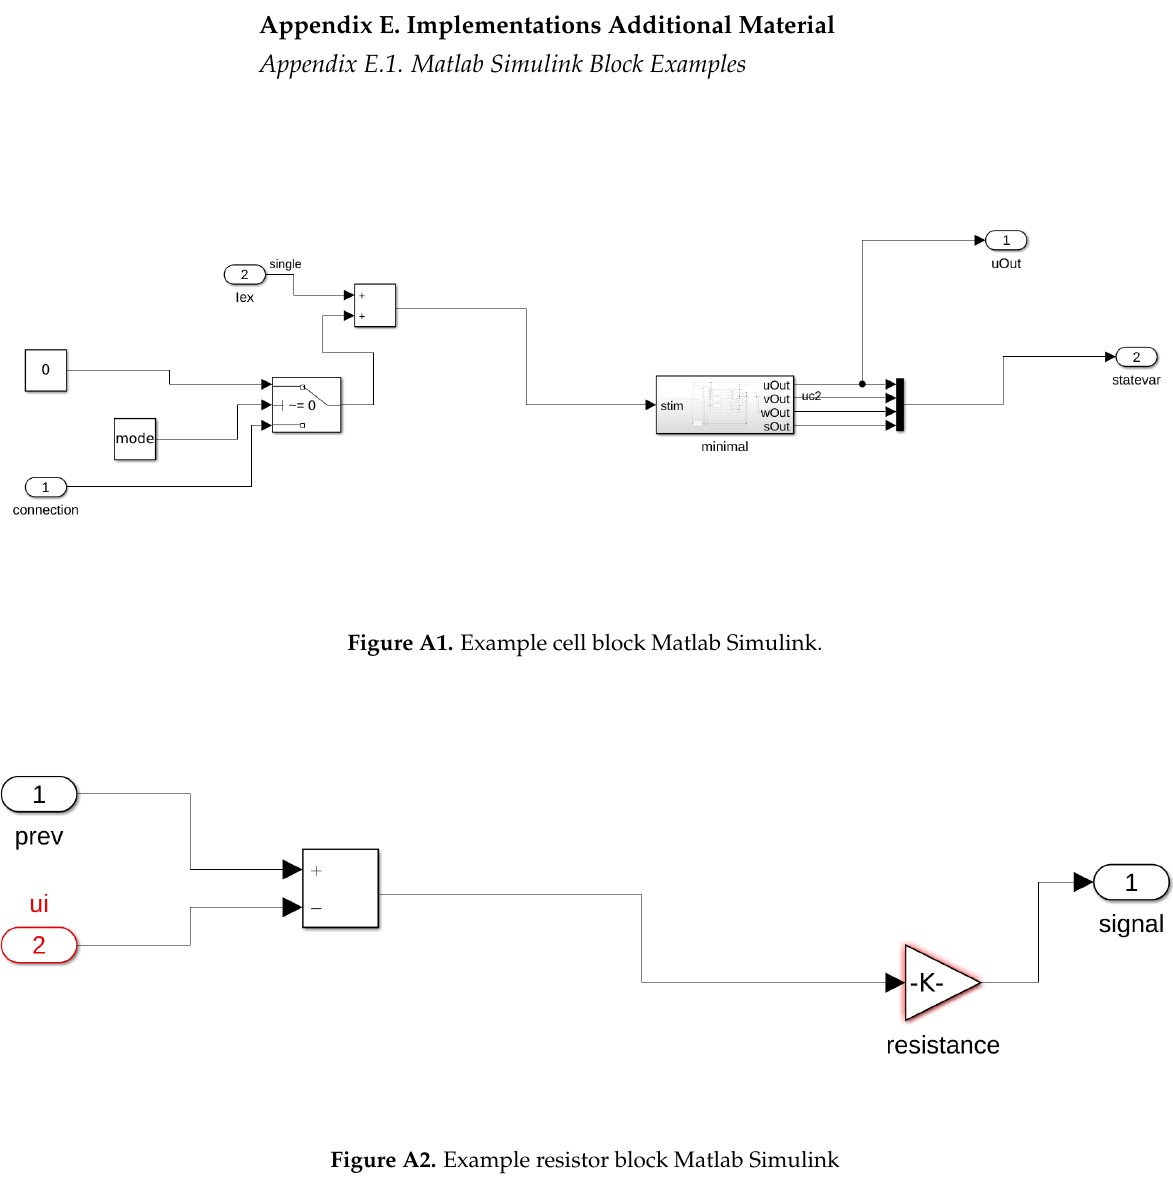
Figure A2. Example resistor block Matlab